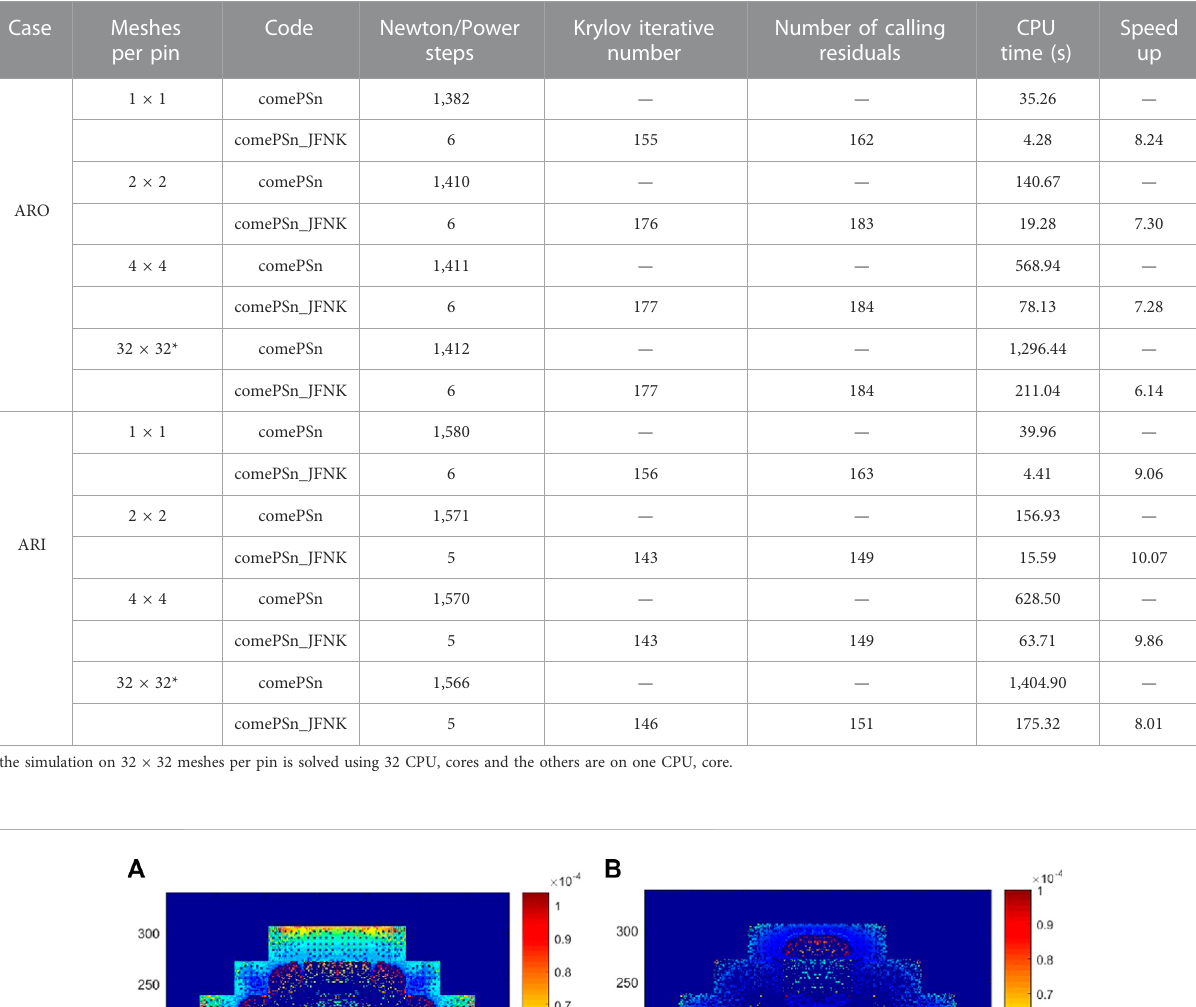
TABLE 2 Comparison of the computational cost for 2-D KAIST-3A benchmark problems.